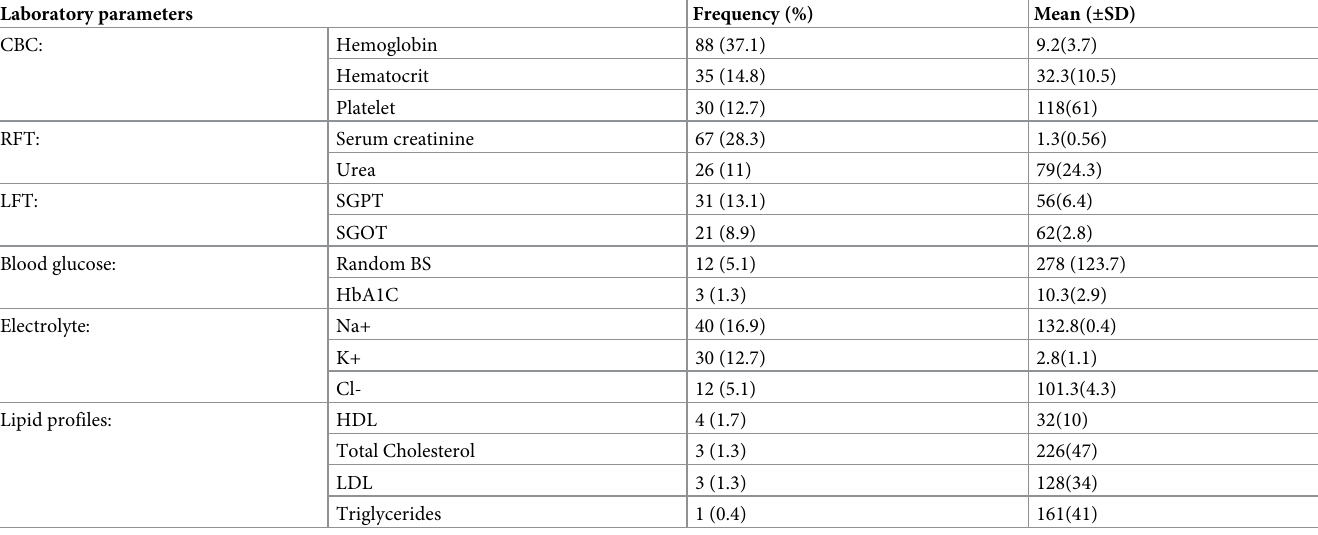
Table 3. Laboratory parameters of hospitalized patients in the UoGCSH medical ward from May 28 to July 26, 2022 (N = 237). Laboratory